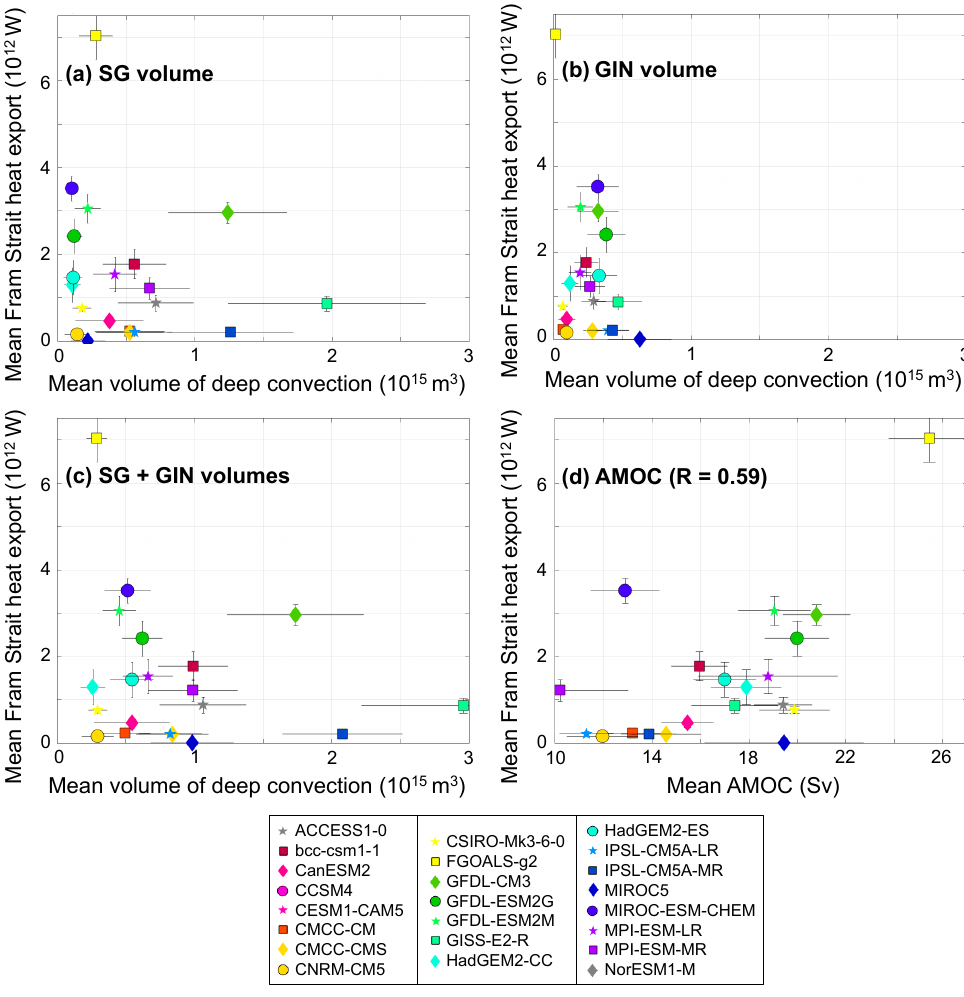
Figure 6. Across-model relationship between the 20-year mean heat export to the Arctic through the Fram Strait and the 20-year mean (a) volume of deep convection in SG; (b) volume of deep convection in GIN; (c) total volume of deep convection SG + GIN; (d) AMOC.